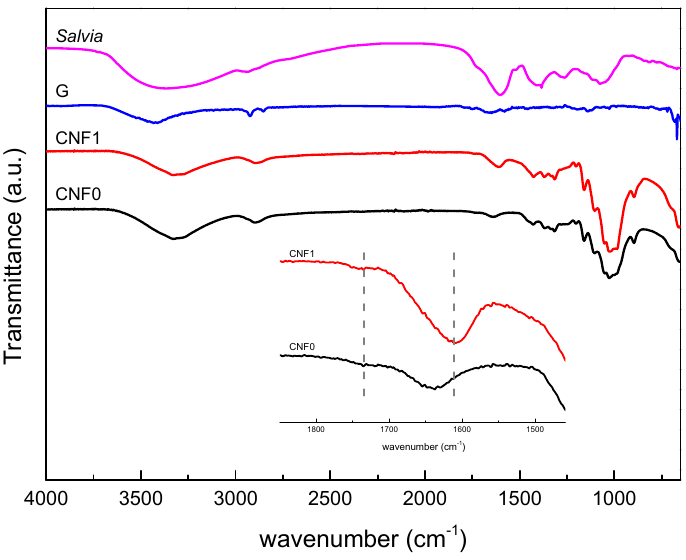
Figure 2. FTIR spectra of CNF0, CNF1, graphene and salvia extract.